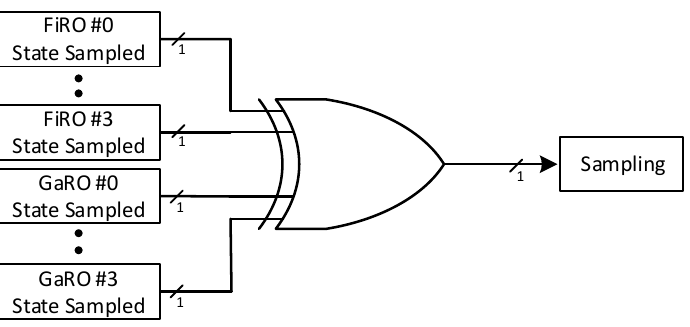
Figure 7. Fibonacci-Galois Ring Oscillator (FiGaRO) four elements